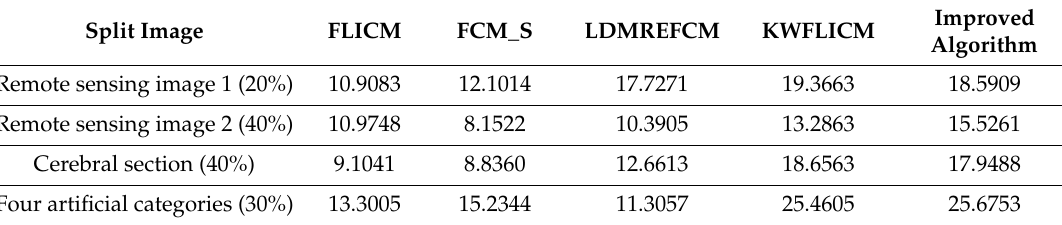
salt-and-pepper noise.